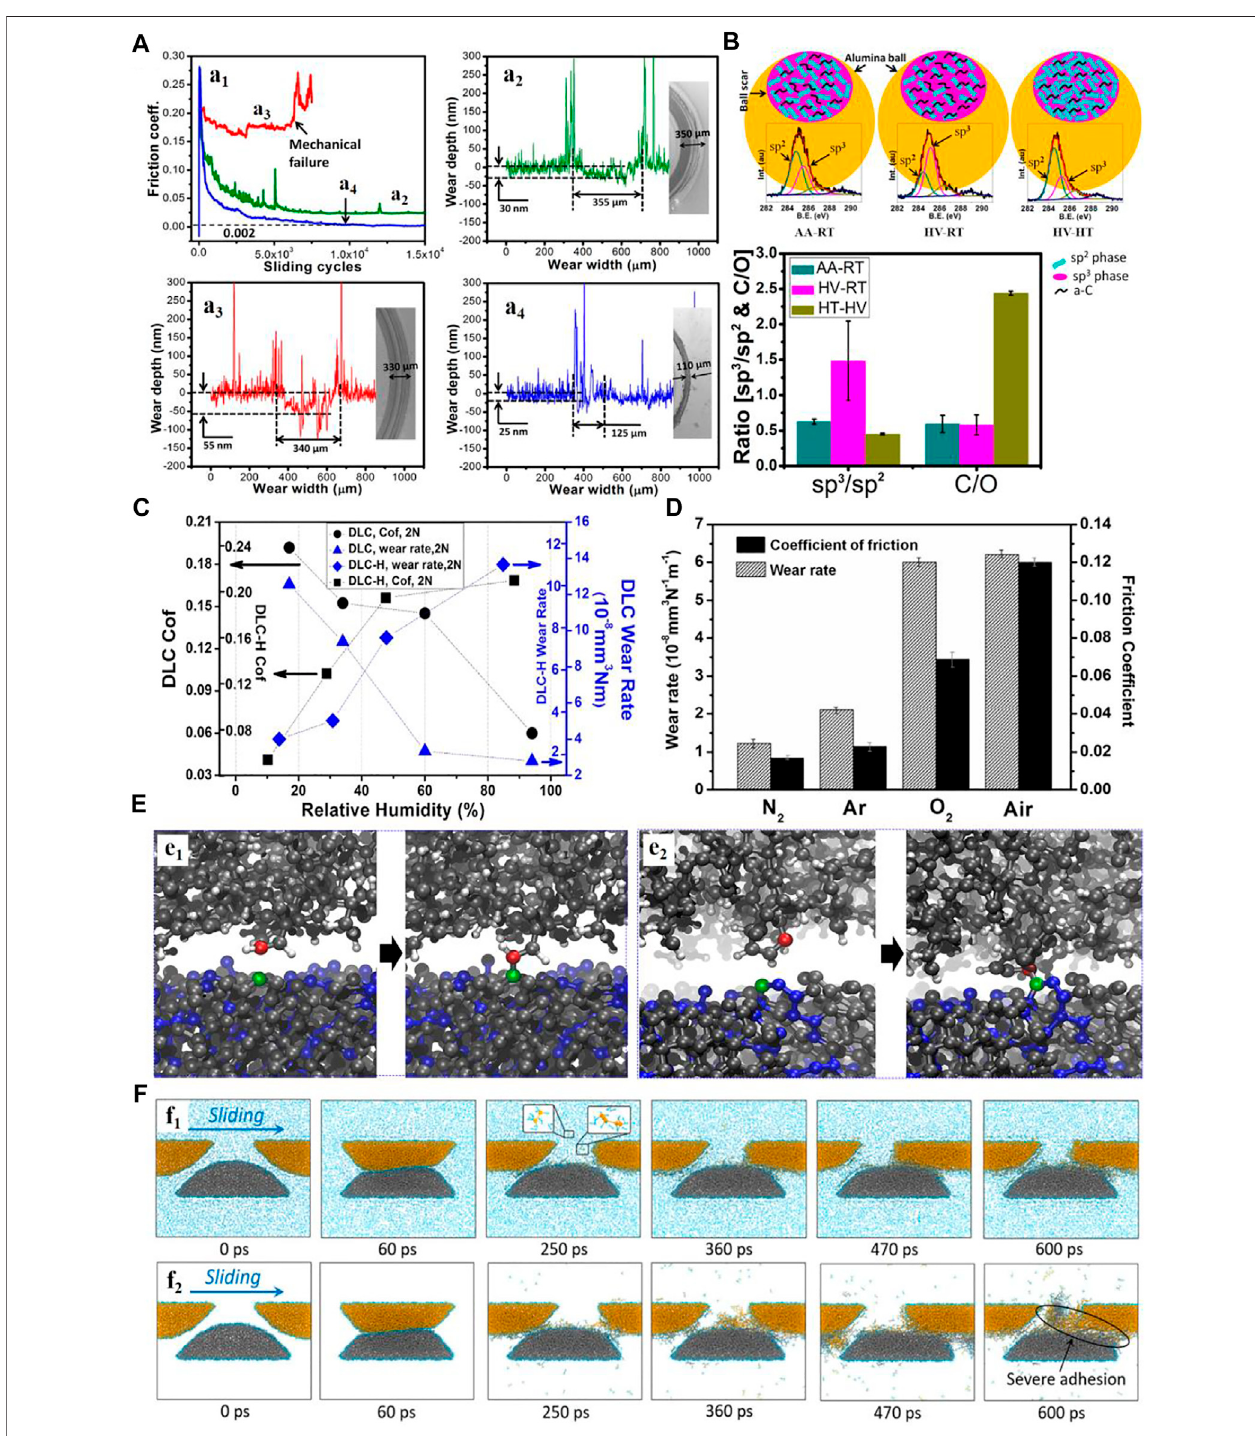
FIGURE2|(A) FrictionbehaviorsoftheUNCDNW fi lmunderdifferentexperimentalconditions(a 1 )andthepro fi lesoftheweartrackformedintheconditionsofAA- RT (a 2 ), HV-RT (a 3 ), and HV-HT (a 4 ). Adapted from Rani et al., 2018b (B) Raman spectra measured in the ball scars formed in the different conditions and the calculated ratios of sp 3 /sp 2 and C/O. Adapted from Rani et al., 2018a (C) Steady-state friction coef fi cients and wear rates of the DLC-H and DLC fi lms depending on the RH. Adapted from Shi et al., 2017a (D) Average friction coef fi cients and wear rates ofthe DLC-H/Al 2 O 3 counterparts in N 2 , Ar, O 2,, and humid air (RH ~ 37%). Adapted from Shi et al., 2017b (E) Interfacial bonds forming between the carbon atoms at the DLC-H coating probe surfaces and the carbon atoms in a diamond grain (e 1 ) or within the grain boundary (e 2 ) at the UNCN surface. Adapted from Vahdat et al., 2014 (F) Snapshots of the sliding behaviors of hydrogen-free DLC asperities in the (f 1 ) hydrogen gas environment and (f 2 ) vacuum. Adapted from Wang et al., 2020.